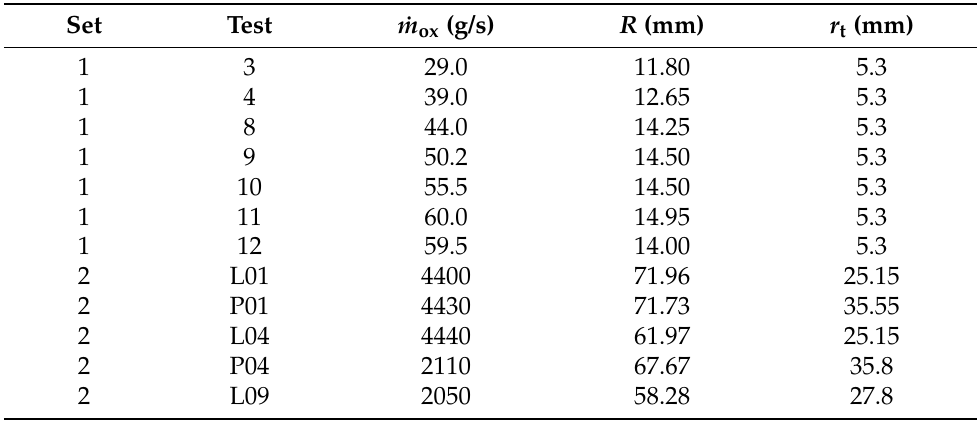
Table 2. Setup conditions for the two hybrid engines considered in this study. Set 1 is taken from [13], while set 2, from